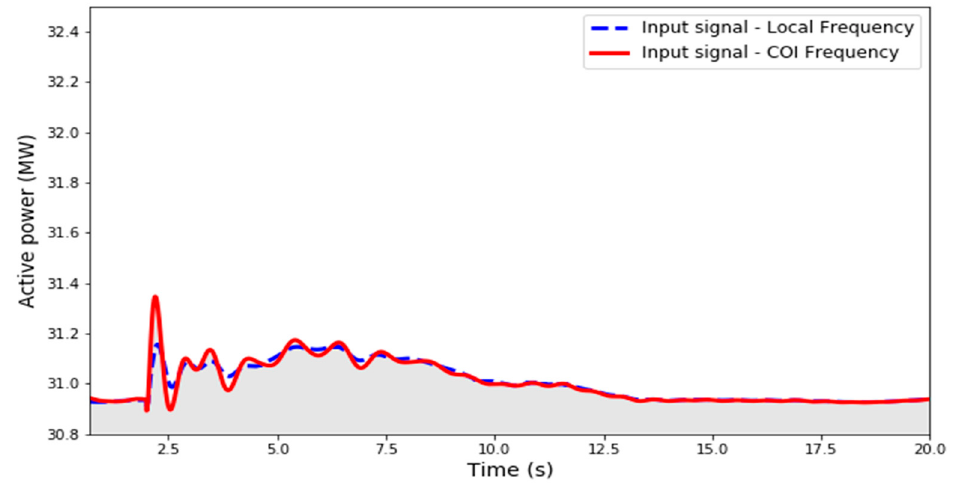
Figure 11. WPP Jelovaca (BIH) active power response comparison.